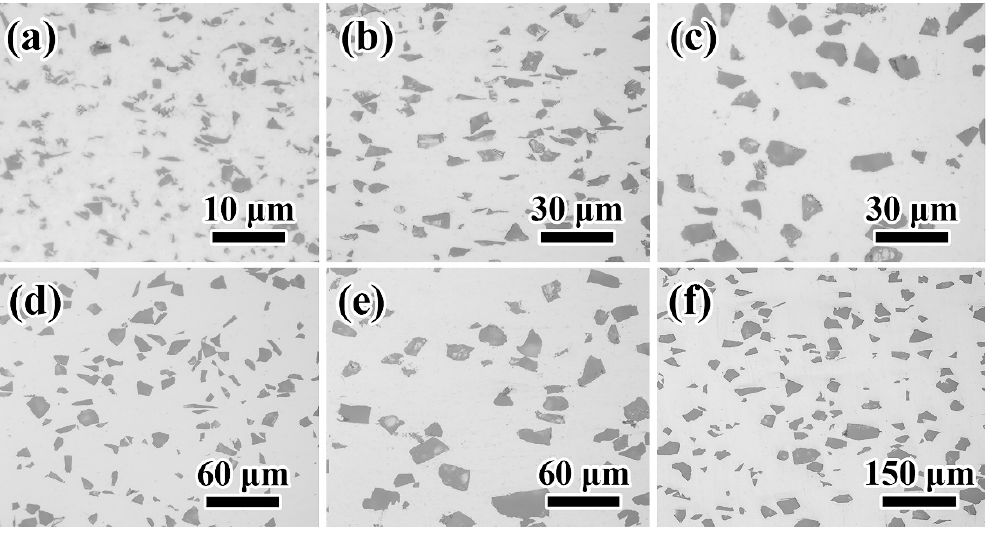
Figure 2. The typical metallograph of ( a ) H-4, ( b ) H-8, ( c ) H-12, ( d ) H-15, ( e ) H-20, and ( f ) H-30.